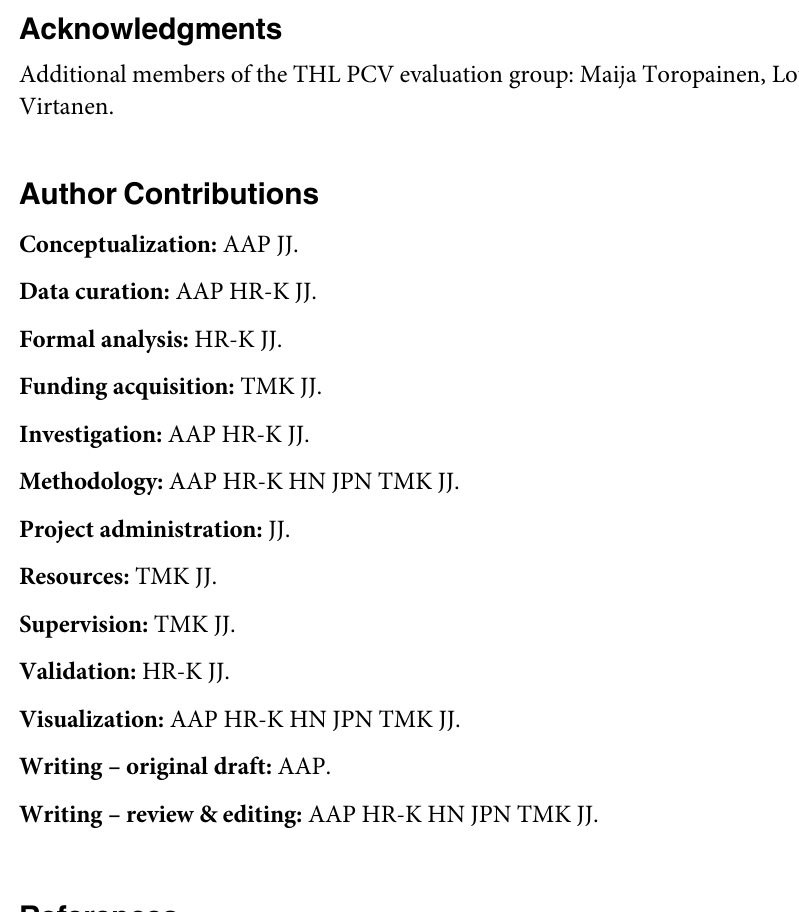
S1 Table. Projected impact against pneumonia in different scenarios and examples from the current study with defined absolute and relative reductions for pneumonia to estimate proportion of pneumococcal pneumonia and vaccine effectiveness estimates. S1 Fig. The incidence of hospital-treated primary pneumonia (HTPP) by age in cohorts of unvaccinated children for evaluation of the indirect impact. S2 Fig. Annual pneumonia rates in children less than 2 years of age by calendar